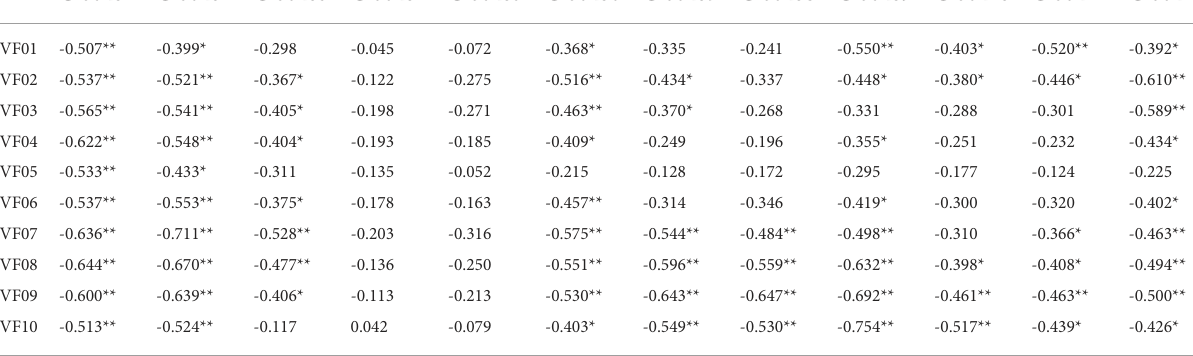
TABLE 2 The correlation coef fi cient of VF and RNFL for the glaucoma group.